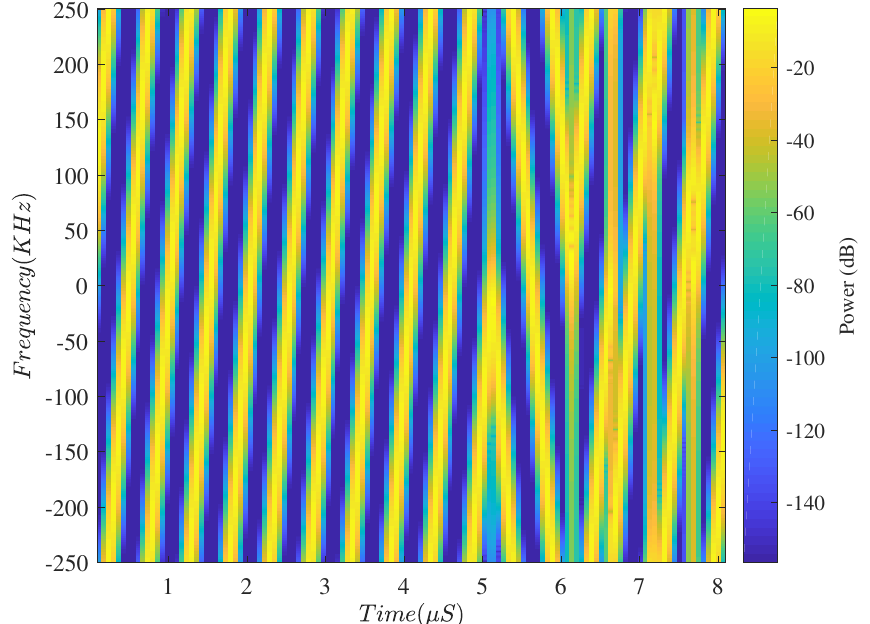
Figure 6. Transmission